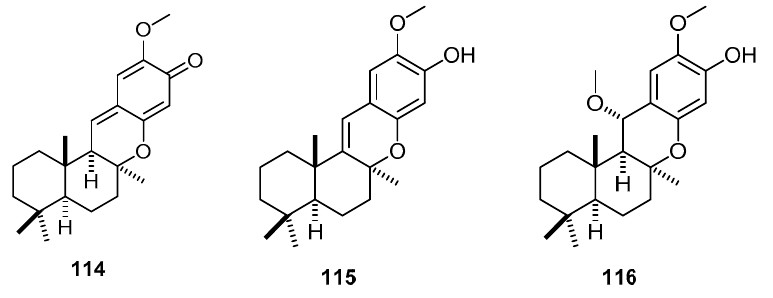
Figure 27. Chemical structures of compounds 114 – 116.